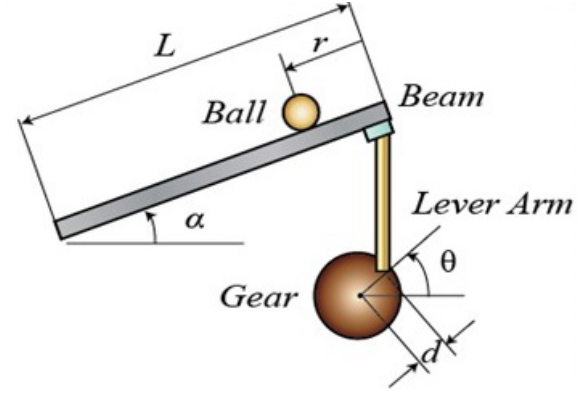
Figure 1: Ball and Beam